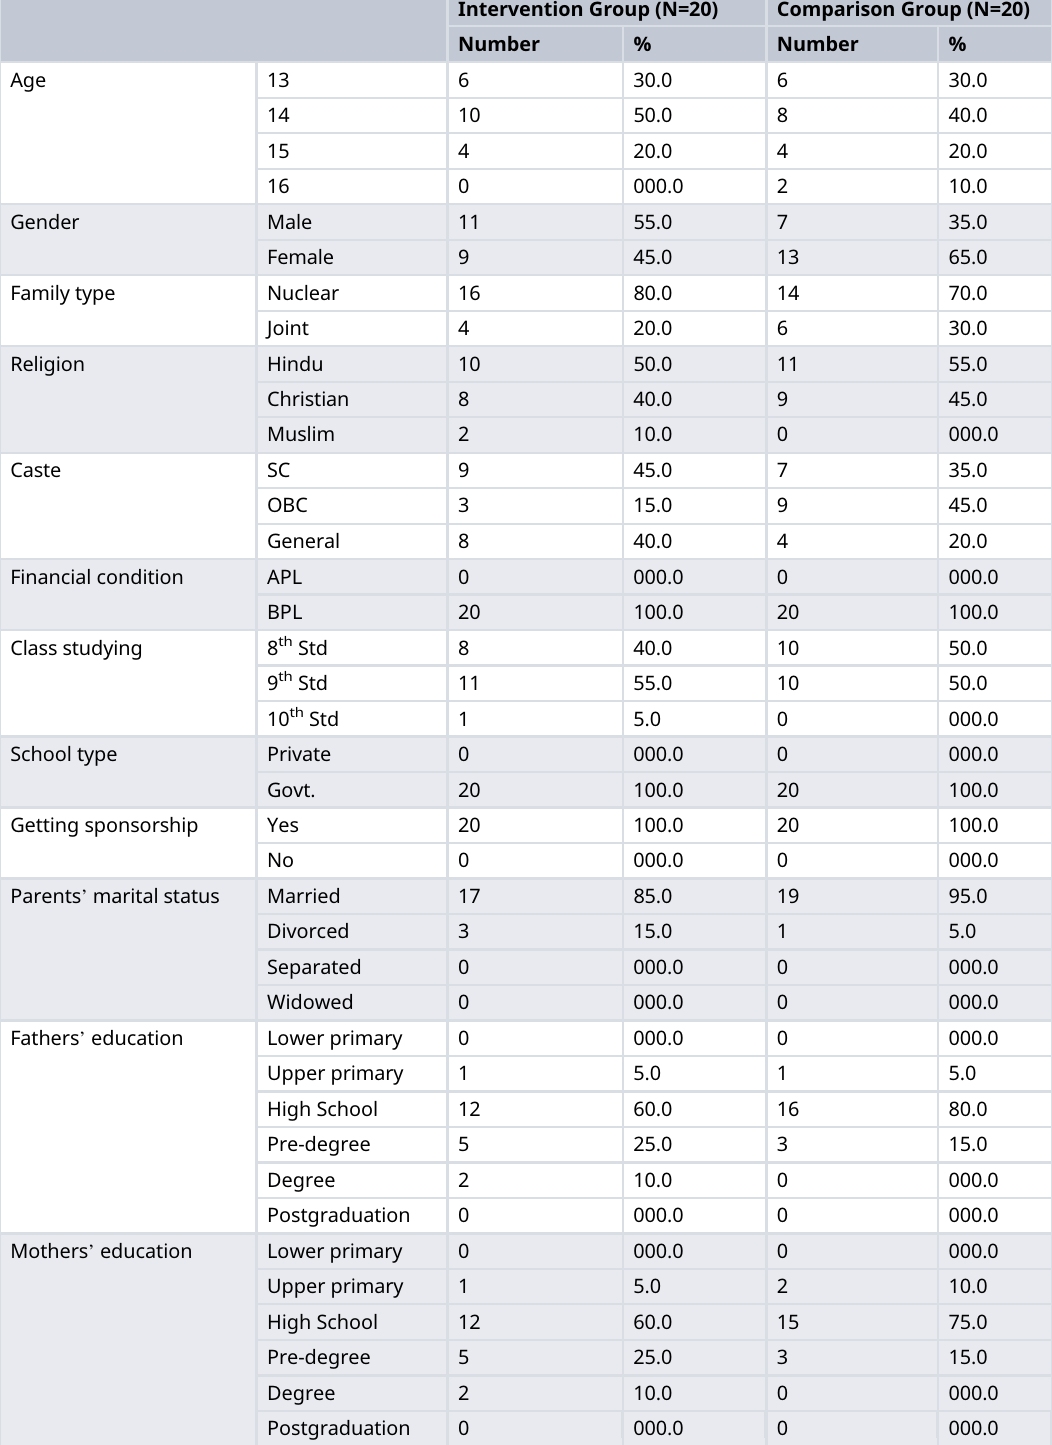
Table 2. Socio-demographic profile of